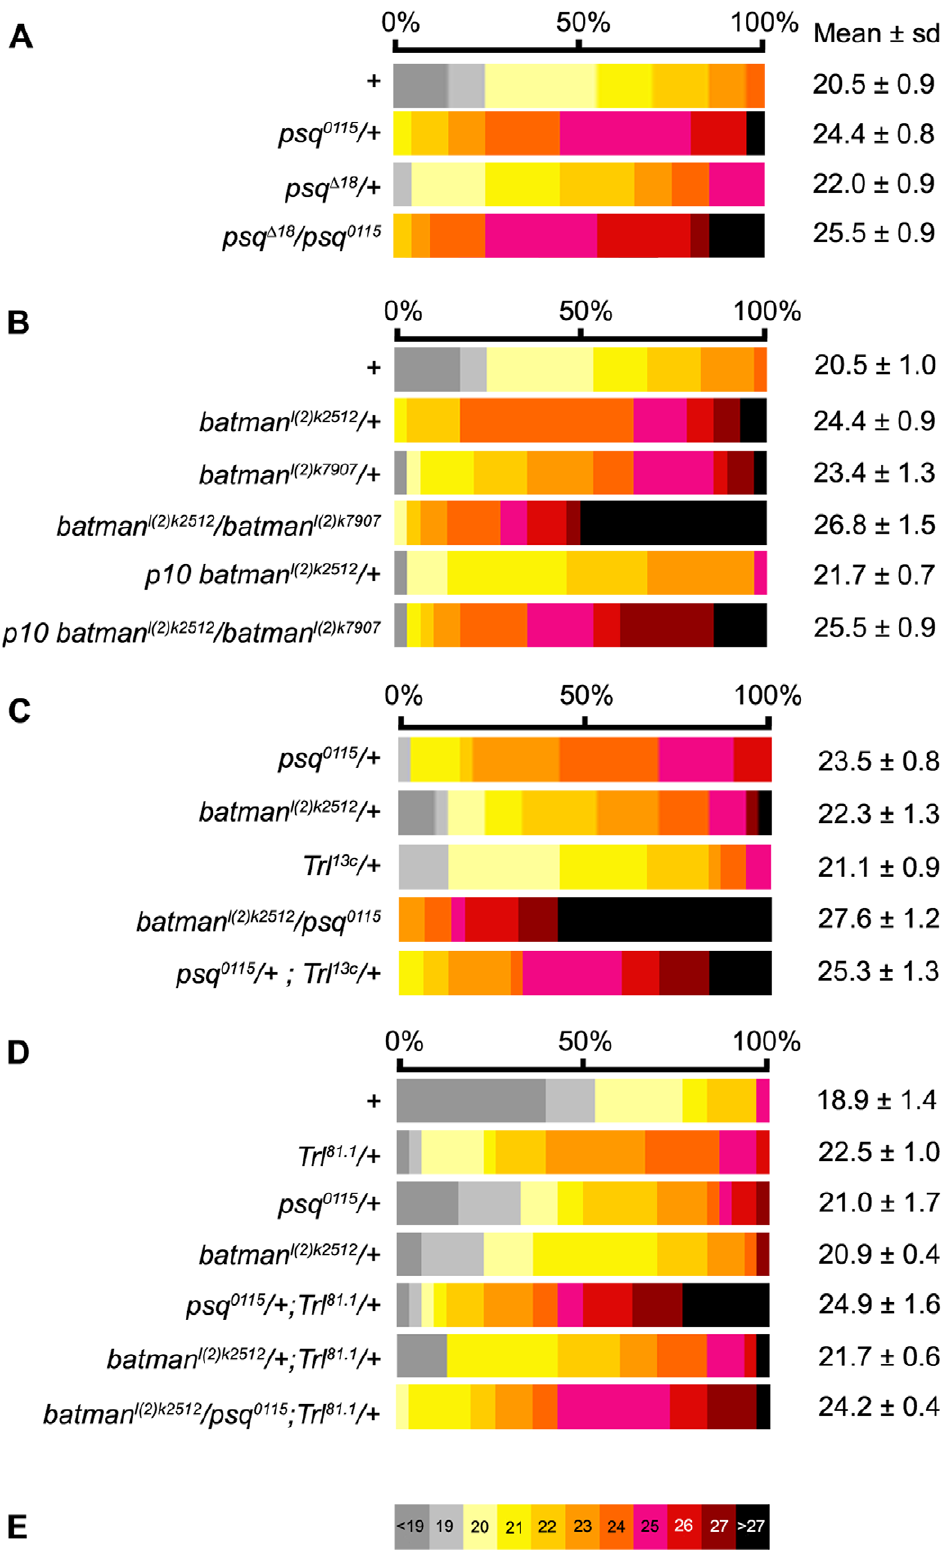
Figure 1. Ovariole number in ttk-BTB group heterozygous combinations. Distribution of the number of ovarioles per ovary in females carrying psq (A), batman (B) and Trl (C) mutant alleles, and in double and triple heterozygotes (C,D). The wild-type control ( + ) corresponds to Canton- S. Each phenotypic class corresponding to the indicated number of ovarioles per ovary was attributed a color as defined on the color table shown in E. The same color table was used in all representations of ovariole number distribution in this Figure and in Figures 2 and 3. The mean number of